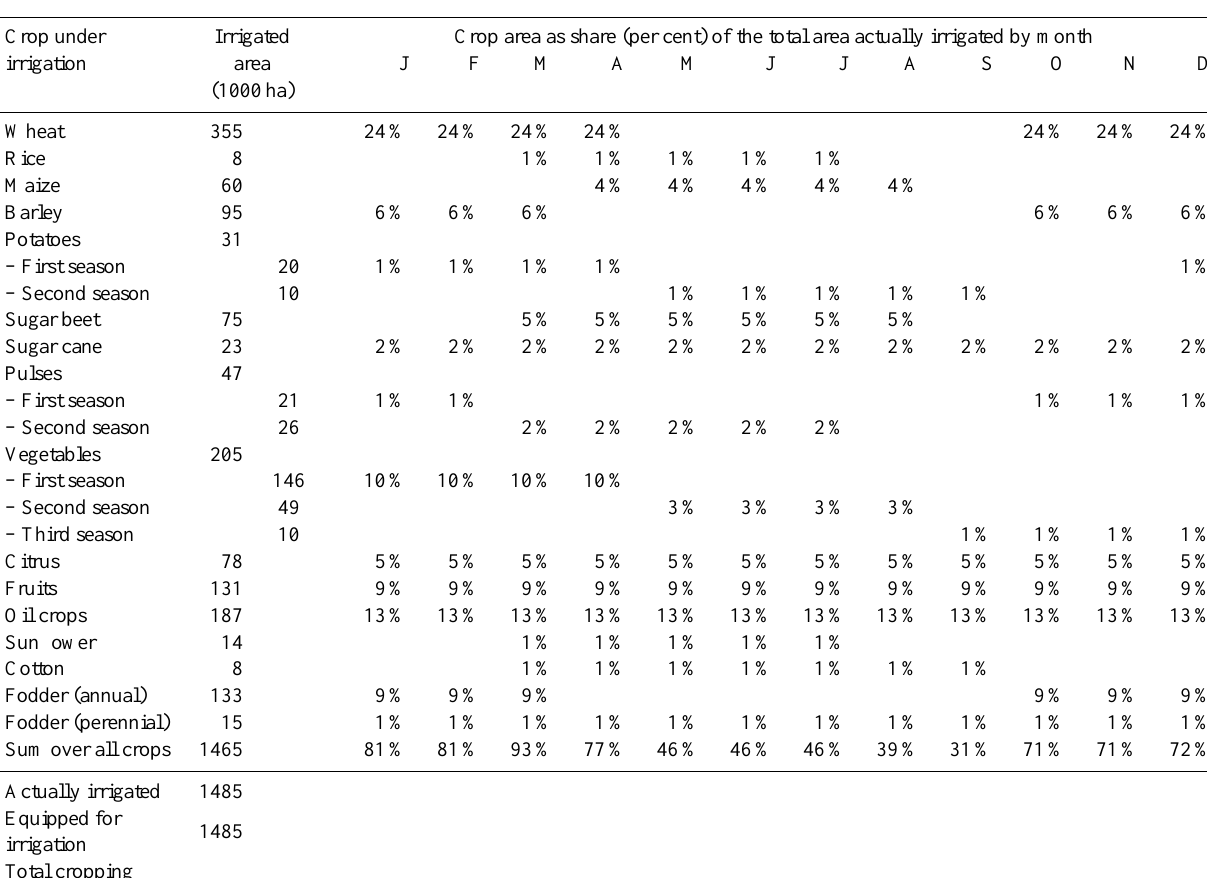
Table 2. Cropping calendar in irrigation for Morocco for the year 2004. Crop under Irrigated Crop area as share (per cent) of the total area actually irrigated by month irrigation